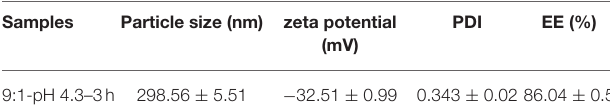
TABLE 1 | Average particle size, zeta potential, PDI, and EE (%) of HAA nanocomposite particles.